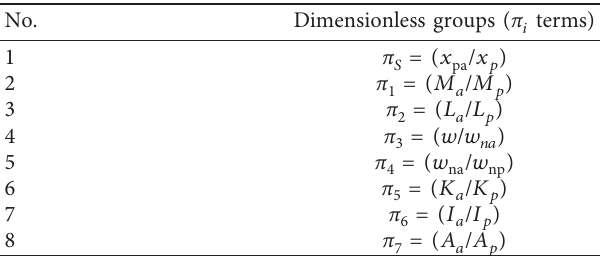
i groups of the beam DVA attached to the pipeline